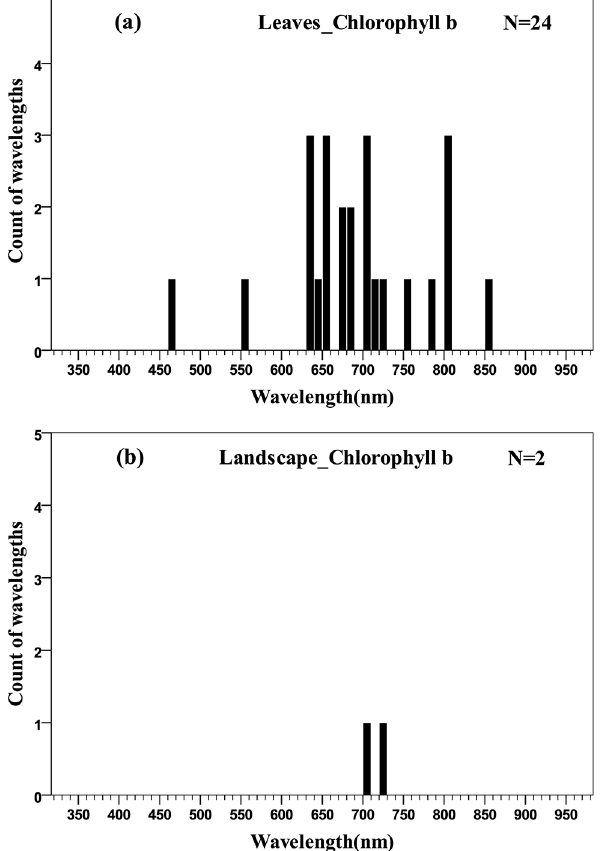
Fig 7. Histogram of wavelengths for chlorophyll b quantification using remotely sensed data at leaf (a) and landscape (b) scales using an interval width of 10